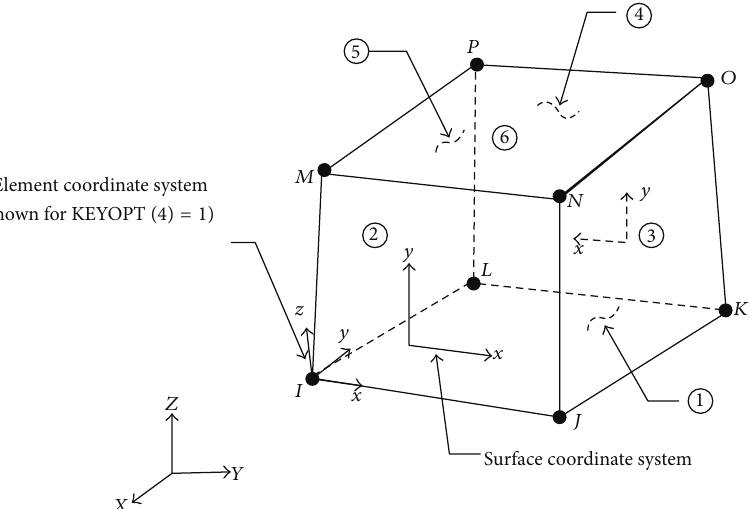
Figure 21: Solid45 element 3D solid (ANSYS12.0).